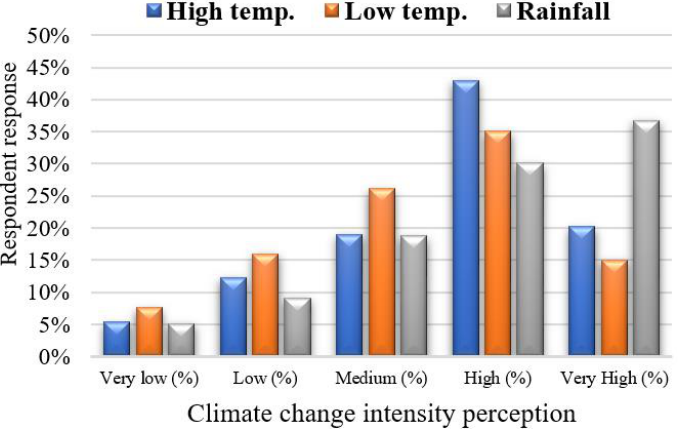
Figure 3. Respondents’ stated perceptions about high/low temperature and rainfall during the past 10 years.